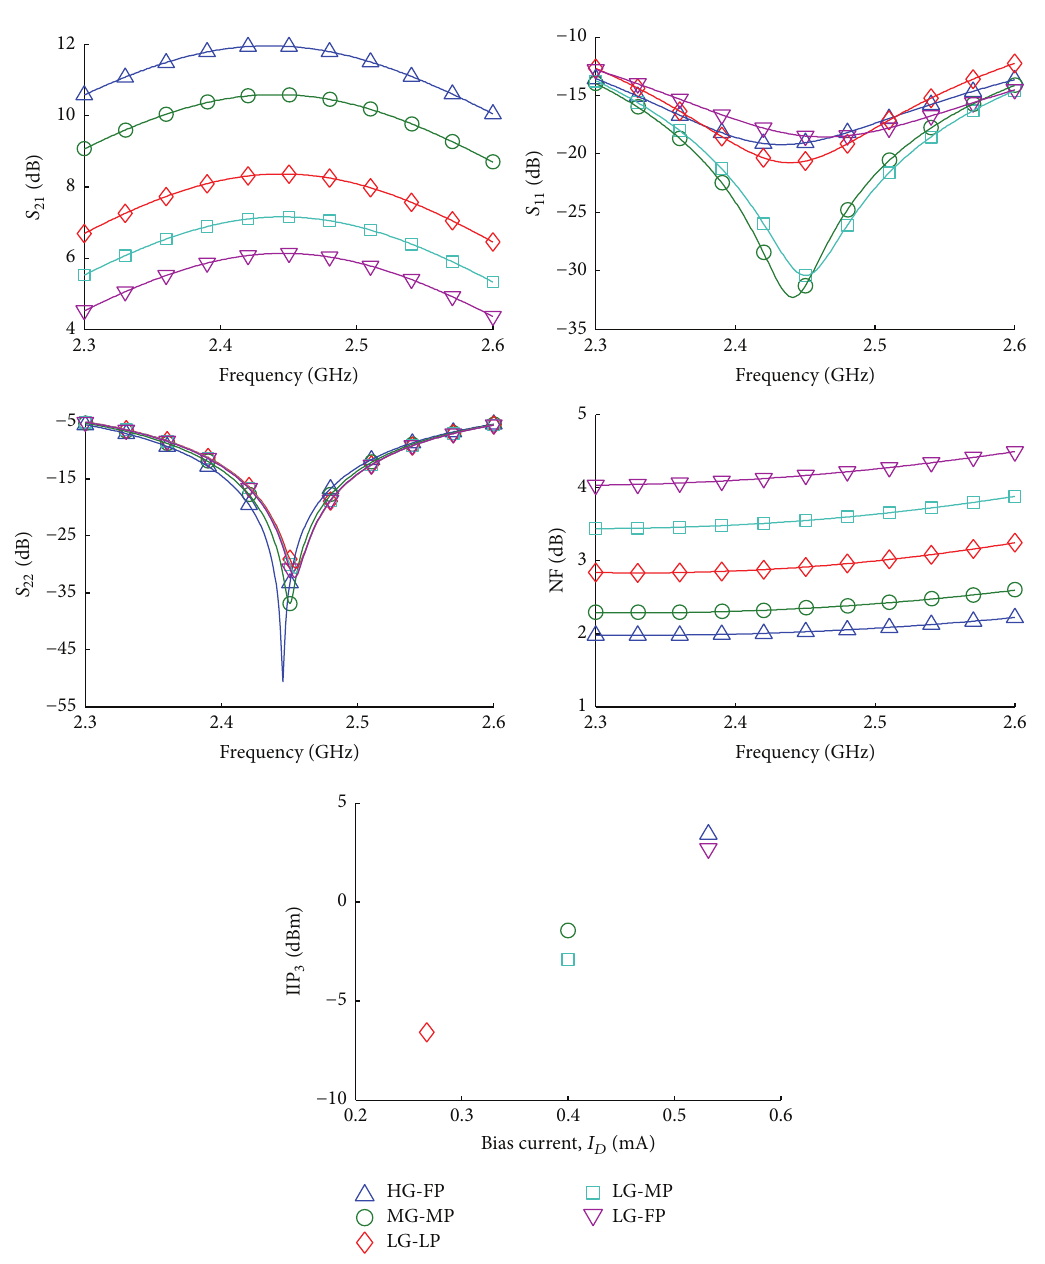
Figure 2: Typical-case simulation